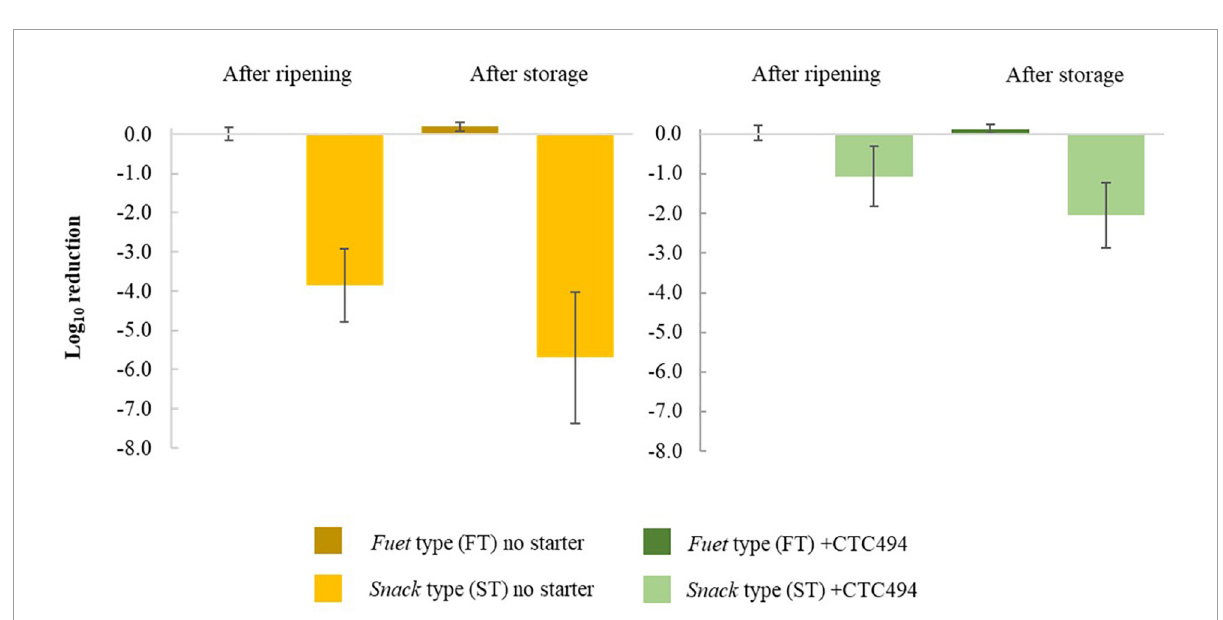
FIGURE6 Inactivation (Log 10 reduction) of L. monocytogenes due to the application of high-pressure processing (HPP) after ripening and storage of fuet -type (FT) and snack-type (ST) sausages spontaneously fermented (no starter) and with the addition of the bioprotective (sakacin K)-producing L. sakei CTC494. Error bars correspond to the standard deviation of the mean